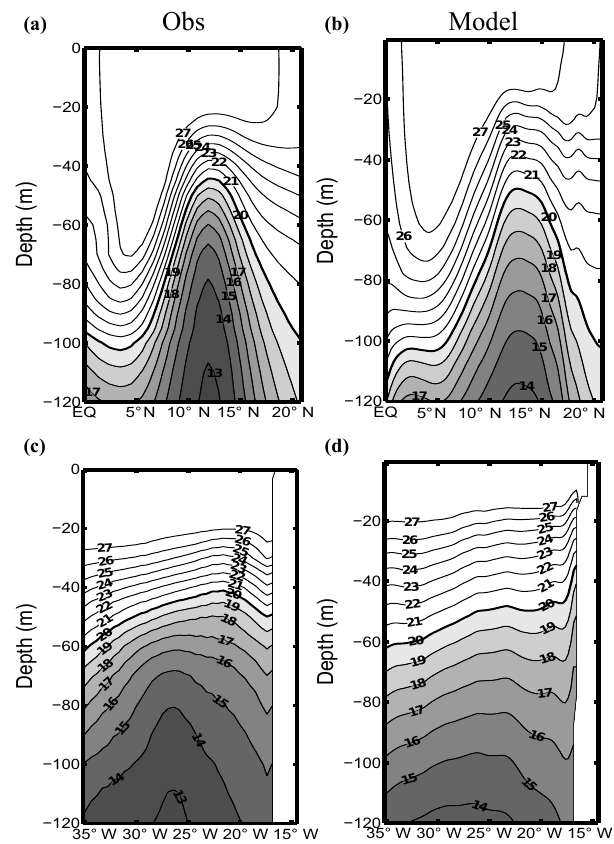
Figure 3. Meridional (zonal) section at 26 ◦ W ( a, b ) (13 ◦ N; c, d ) for temperature ( ◦ C) averaged during September–October. Obser- vations and models respectively correspond to panels (a, c) and (b, d)